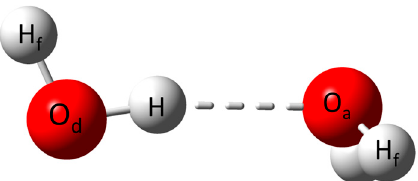
Figure 1. Water dimer describing the notation used to identify the atoms involved in the HBs.